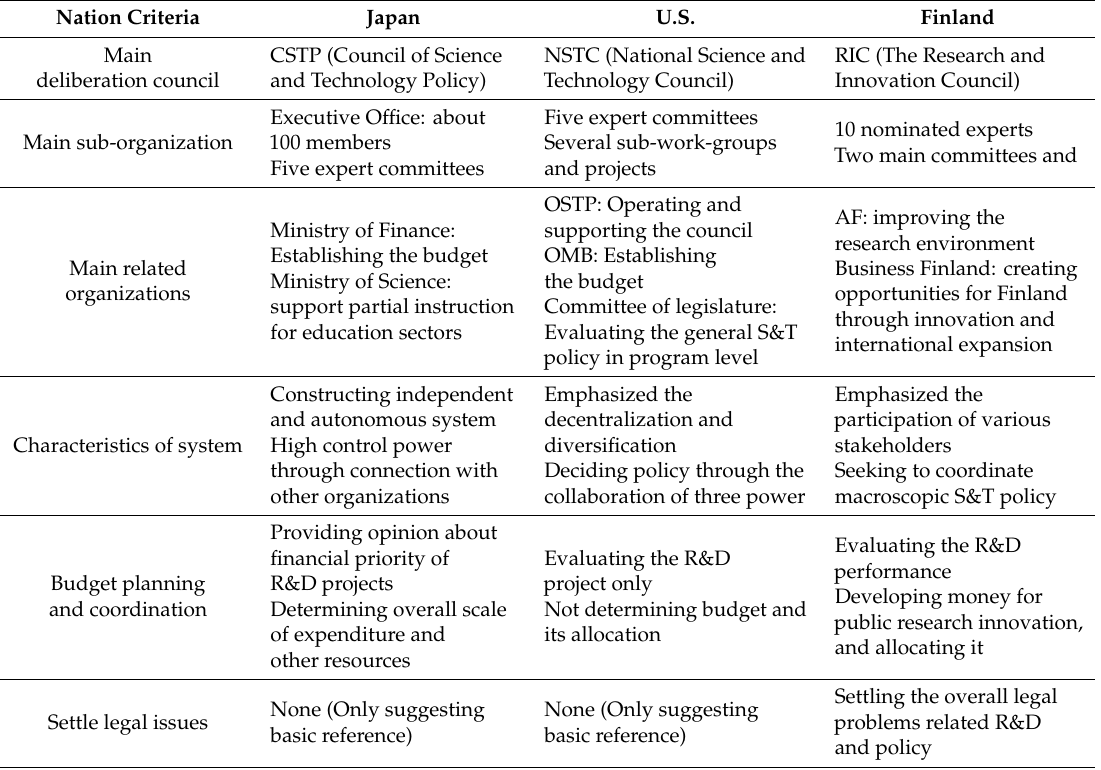
Table 5. Comparison of S&T councils in Japan, the U.S., and